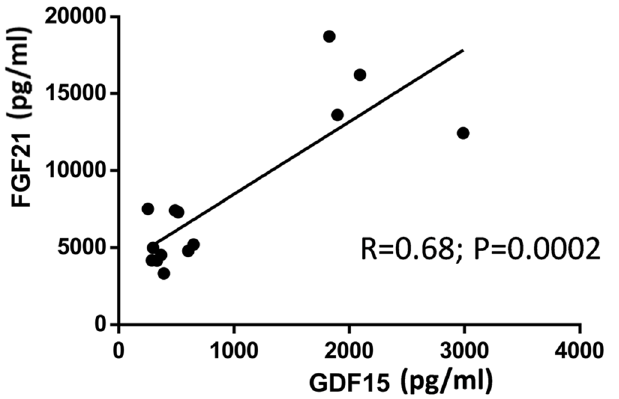
Fig 6. Correlation analysis between GDF-15 and FGF-21 protein levels. in the conditioned medium of C2C12 cells treated with respiratory chain inhibitors.